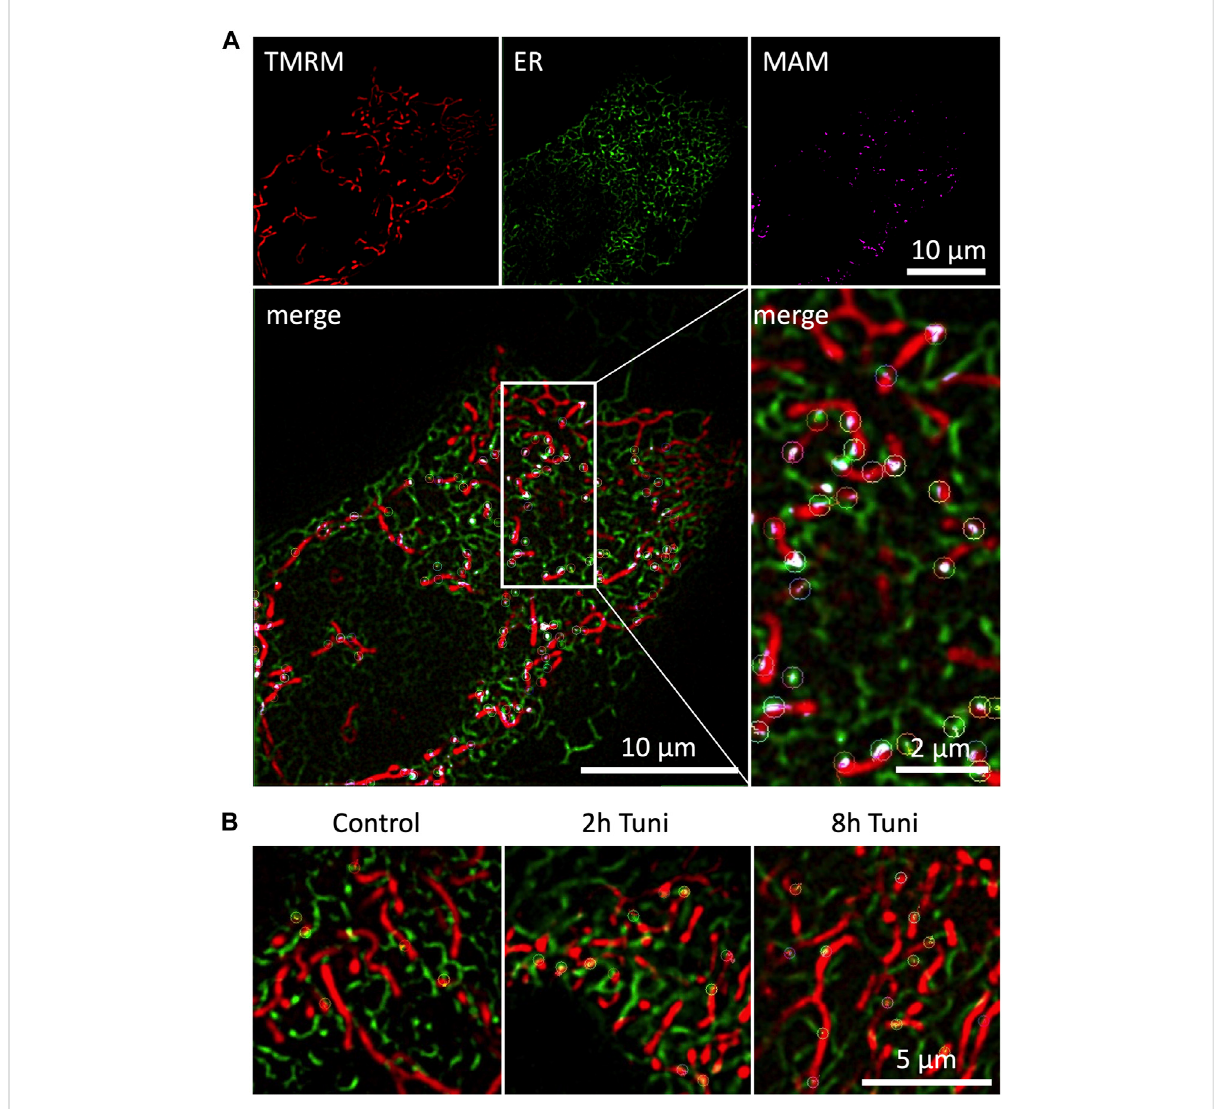
Duration of dynamic ER-mitochondria interactions are prolonged during ER-stress. (A) HeLa cells expressing the ER marker ERAT4.01 NA were labeled with 100 nM TMRM and imaged with SIM microscopy. Pixel-wise multiplication of mitochondrial and ER fl uorescence followed by a signal ampli fi cation resulted in a representation of mitochondrial associated ER membranes (MAM), which were tracked over time and highlighted with color coded circular markers. (B) HeLa cells expressing the ER marker ERAT4.01 NA were labeled with 100 nM TMRM and treated with 0.6 µM tunicamycin for two or 8 h or the respective DMSO control. Tracked MAMs are highlighted with color coded circular